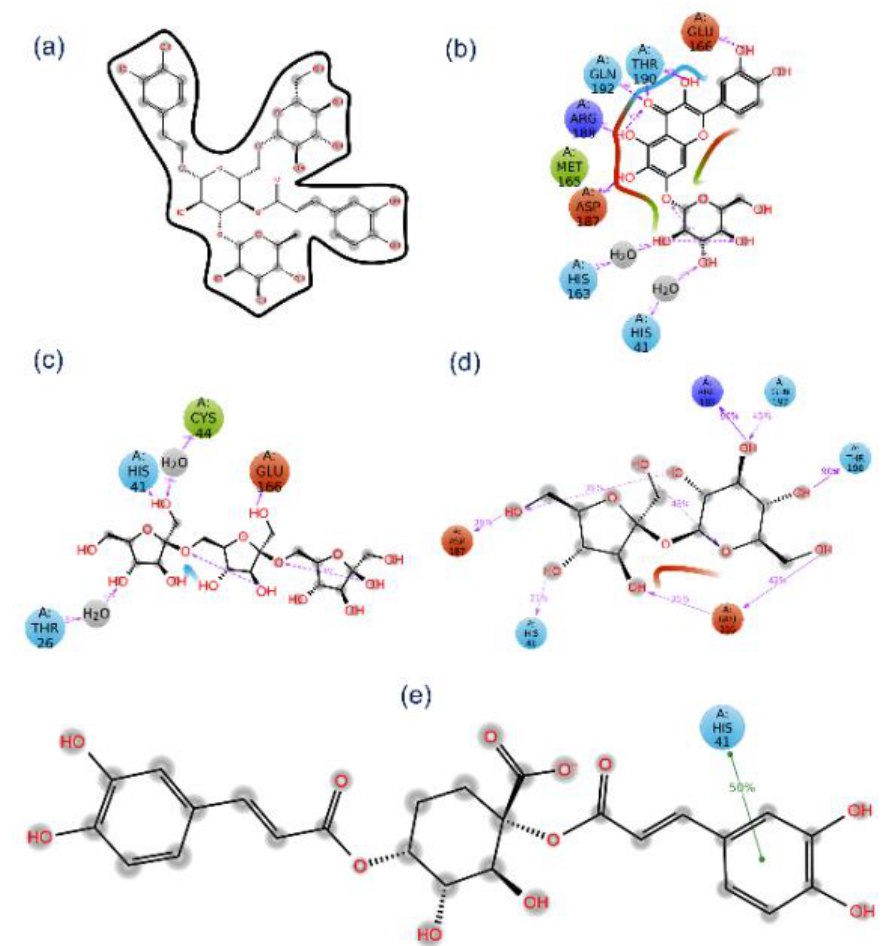
Figure 8. 2D interaction diagrams for docked SARS-CoV-2 M pro -potential natural products, i.e., ( a ) Echinacoside, ( b ) Quercetagetin 7-glucoside, ( c ) Levan N, ( d ) Inulin from chicory, and ( e ) 1,3-Dicaffeoylquinic acid, are generated at 30% of the total 100 ns MD simulation interaction